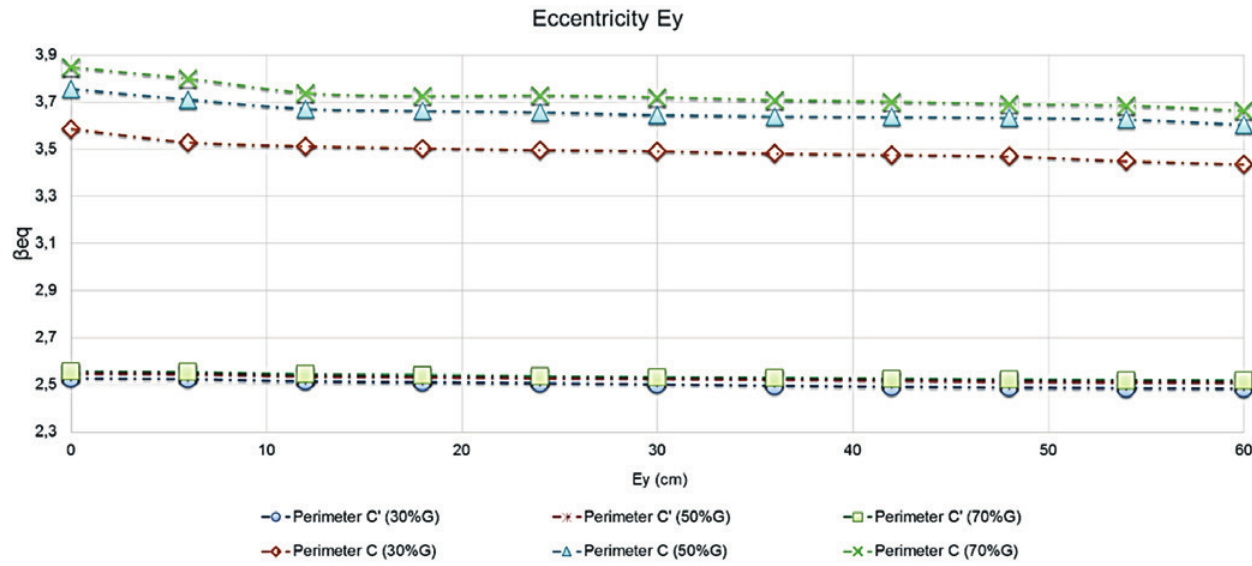
Results of reliability index